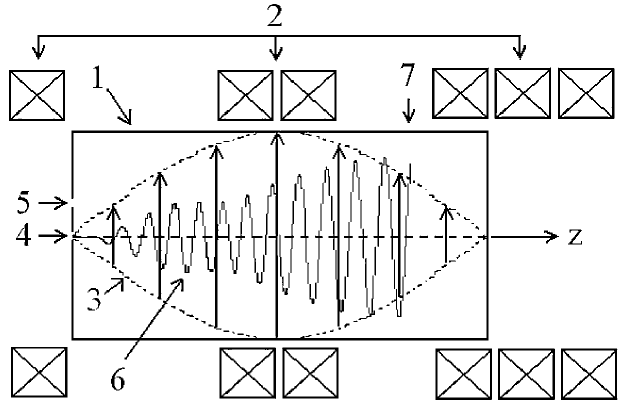
FIG. 1. A physical model scheme: 1—cavity, 2—magnetic coils, 3—electric field profile (particular case of TE 111 mode), 4—on-axis injection point, 5—off-axis injection point, 6—elec- tron trajectory, 7—stop